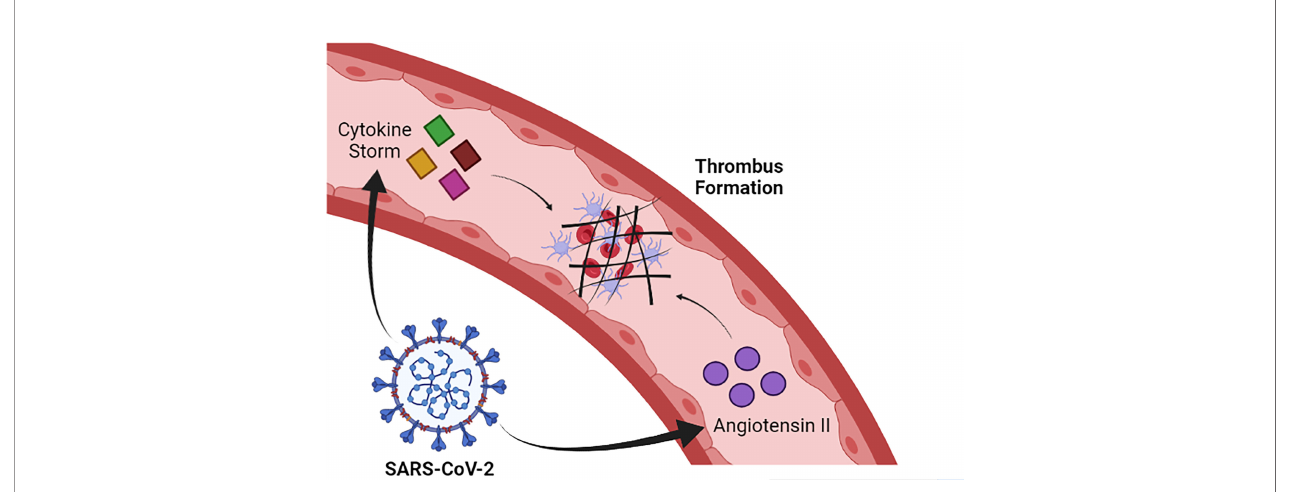
FIGURE 2 | SARS-CoV-2 induces cytokine storm formation and increased levels of angiotensin II. Such alterations contribute to the activation of the coagulation cascade and, consequently, to thrombus formation. Image created in: